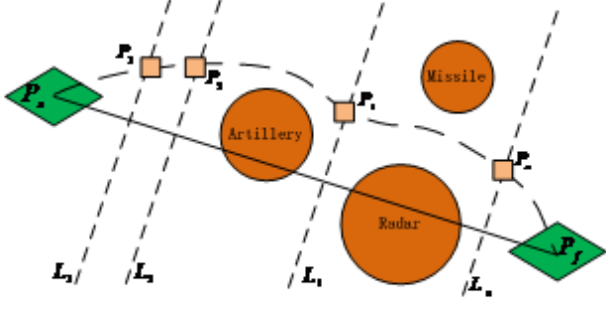
Fig. 1 Typical 2D LAV battlefield